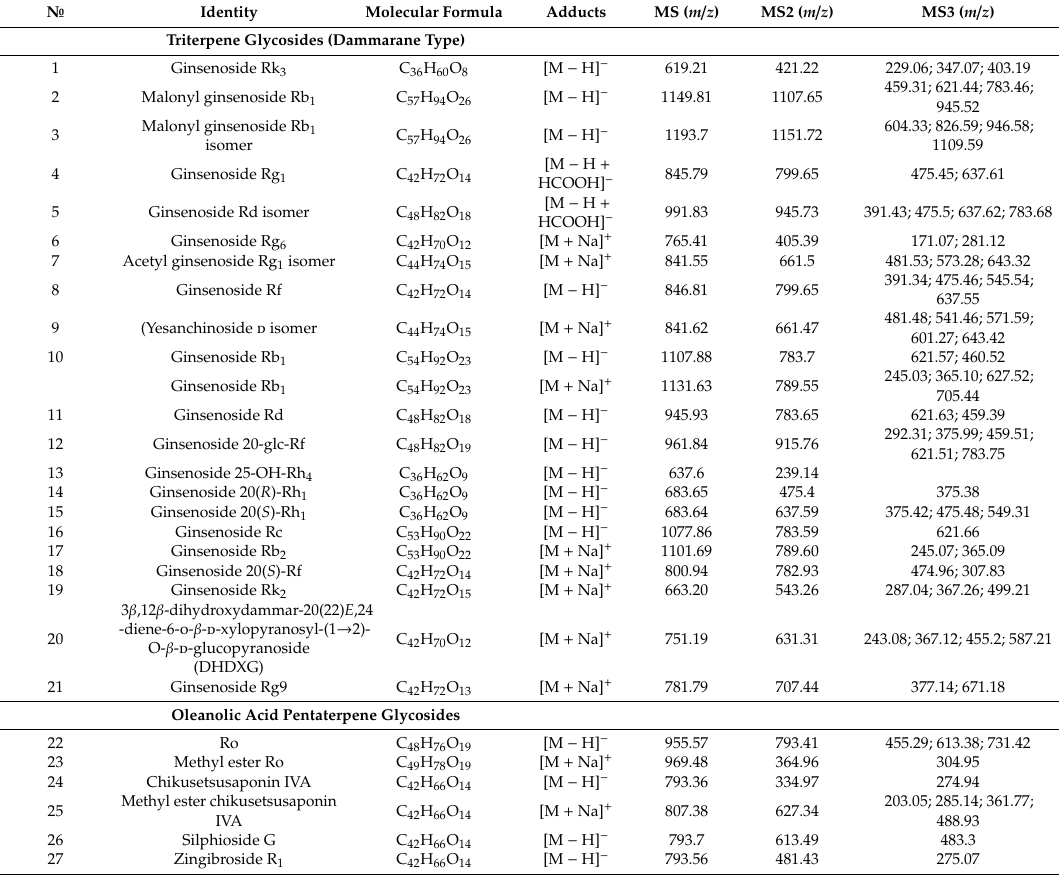
Table 1. Components identified from the supercritical extract of P. ginseng